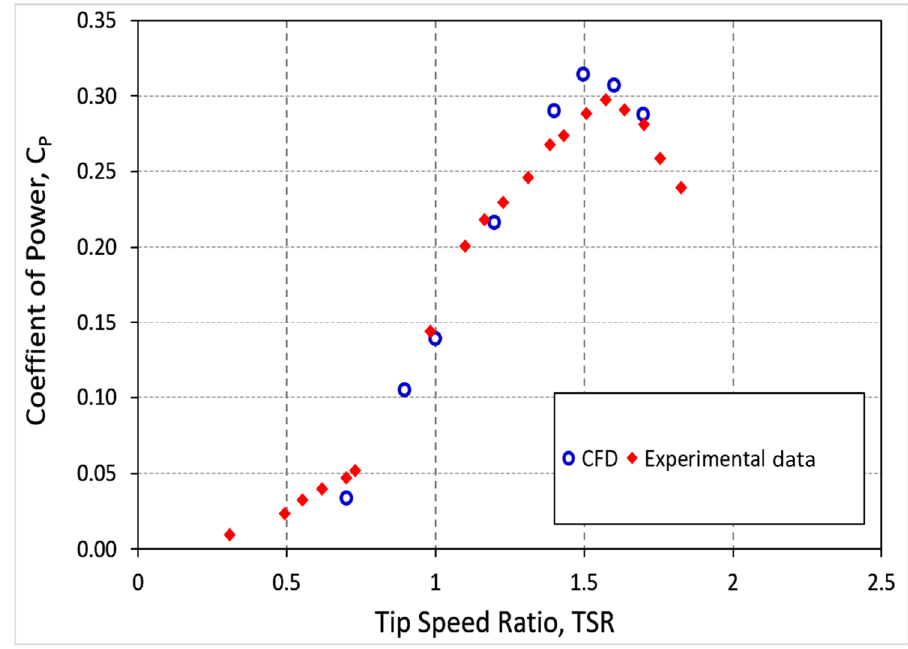
Figure 1. ANSYS-Fluent CFD C P - TSR curve vs. experimental data, concerning tests in a wind tunnel performed at a flow speed of 10 m/s. TSR : Tip Speed Ratio.